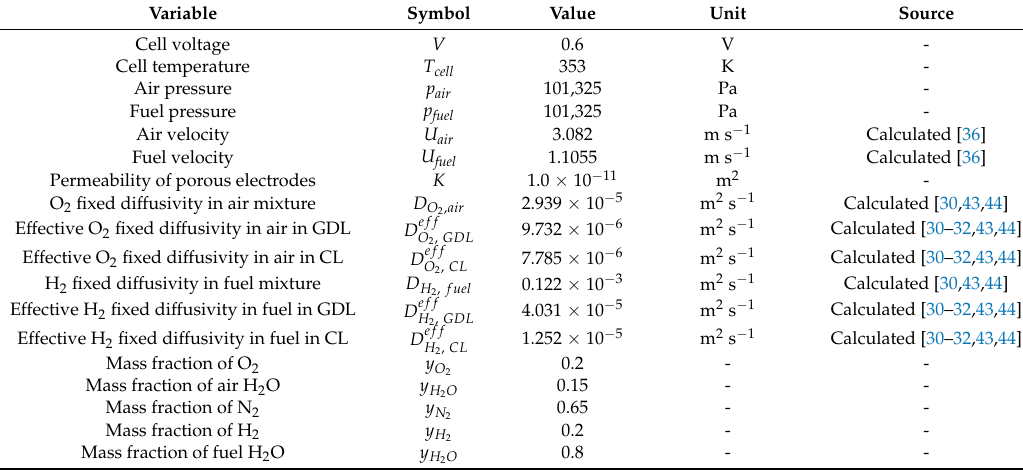
Table 6. Case study operating